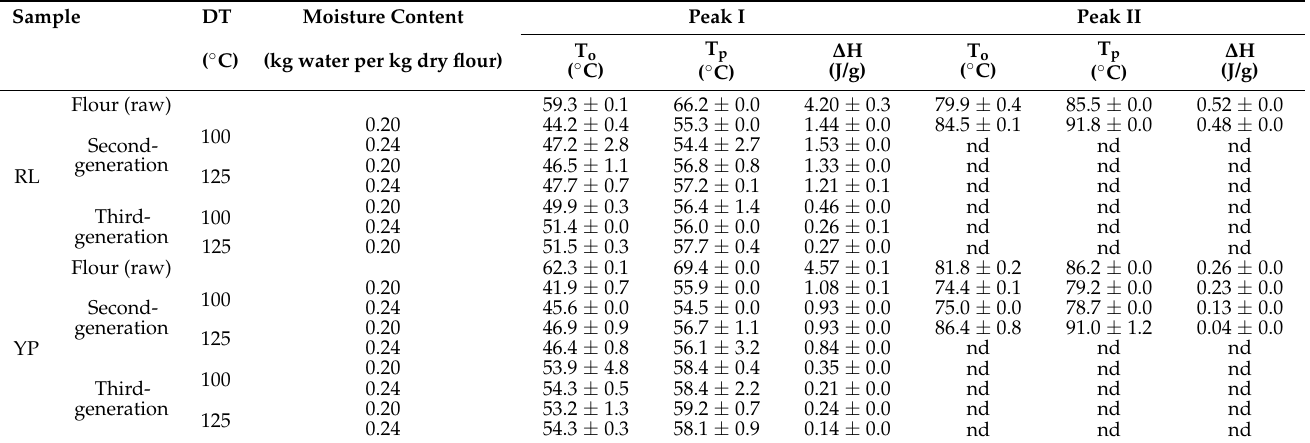
Table 4. Thermal properties of red lentil (RL) and yellow pea (YP) flours and their products as a function of die temperature (DT) and moisture